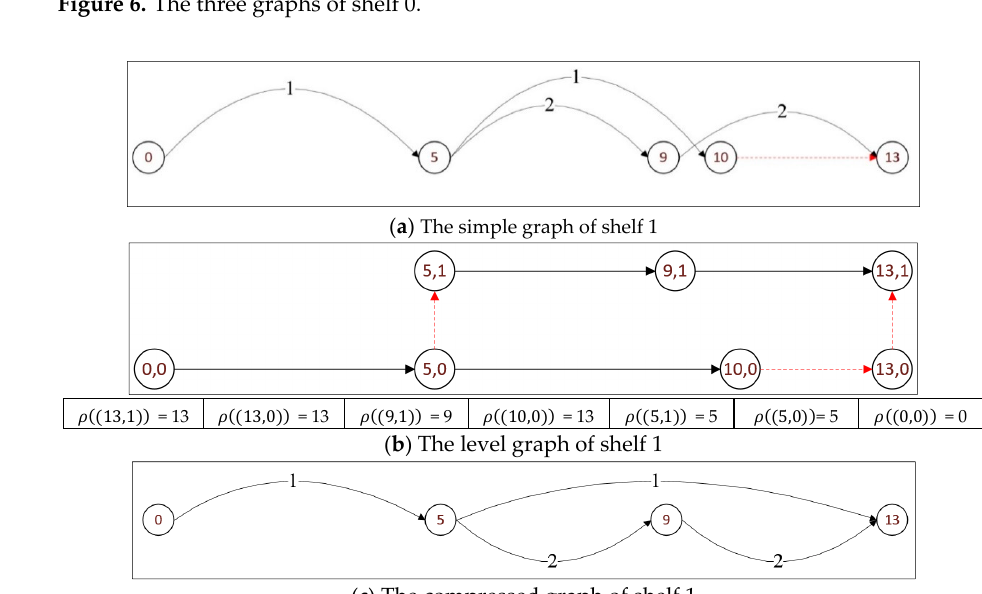
Figure 7. The three graphs of shelf 1.